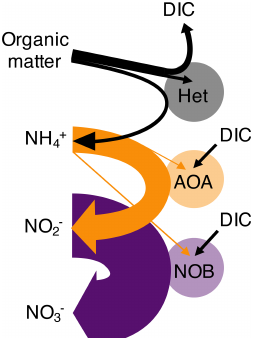
Figure 1. Schematic of the nitrogen remineralization sequence driven by microbial functional types. Organic matter is consumed by heterotrophic organisms (Het), with ammonium (NH + ) and 4 dissolved inorganic carbon (DIC) as waste products. Chemoau- totrophic ammonia-oxidizing archaea (AOA) consume NH + and 4 excrete nitrite (NO − ). Chemoautotrophic nitrite-oxidizing bacte- 2 ria (NOB) consume NO − and excrete nitrate (NO − ). AOA and 2 3 NOB may assimilate NH + (as illustrated) or simple organic ni- 4 trogen compounds. Straight arrows indicate the substrates used for biomass synthesis, while horseshoe-shaped arrows indicate respi- ration substrates and products. The widths of each of the arrows correspond to the metabolic budgets used in this study. For exam- ple, NOB require significantly more NO − than the amount of NH + 2 4 required by AOA to produce the same amount of biomass. Though not indicated, heterotrophs may also fix DIC in the dark